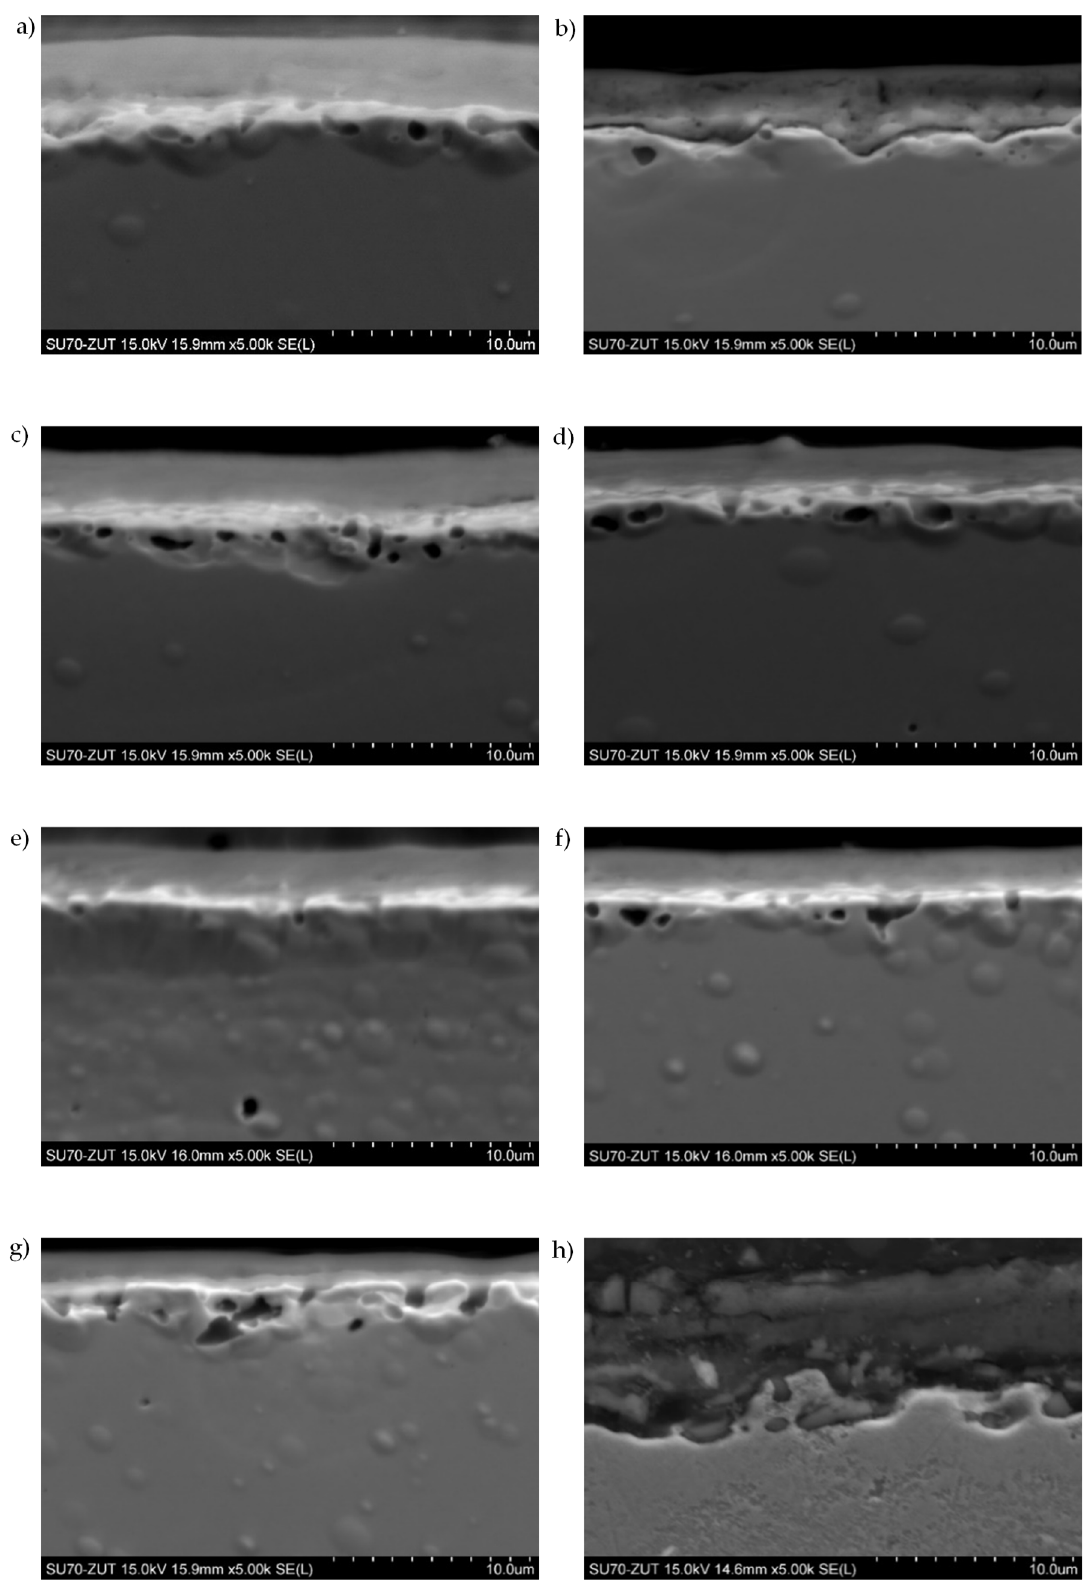
Figure 2. Secondary electron images of oxide layers on samples obtained during the carried-out tests for: ( a ) C 23#1 , ( b ) H 23#1 , ( c ) H 23LS#1 , ( d ) C 27#1 , ( e ) C 27LS#1 , ( f ) C 30#1 , ( g ) C 30LS#1 , ( h ) C 27#2